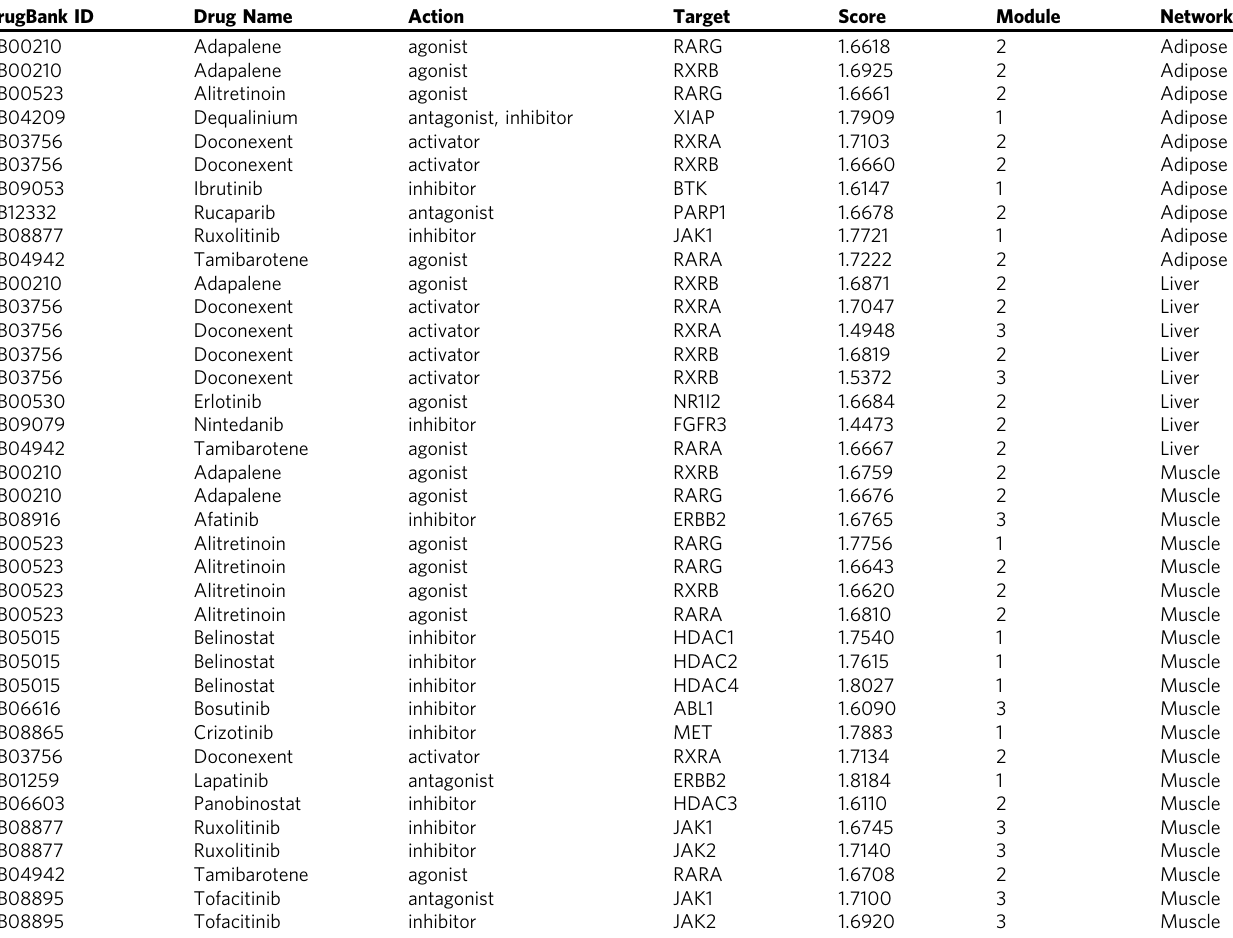
Table 1 List of the drugs identi fi ed as possible repurposing candidates DrugBank